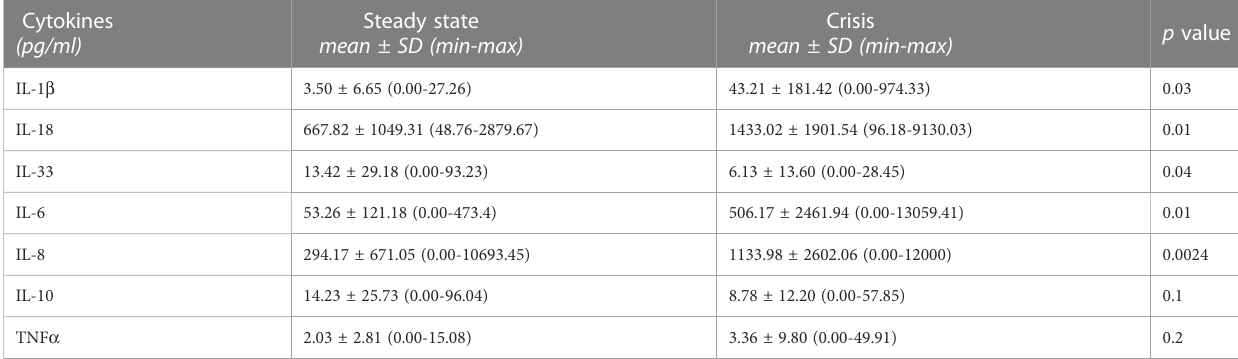
TABLE 2 General cytokines pro fi le of the SCD